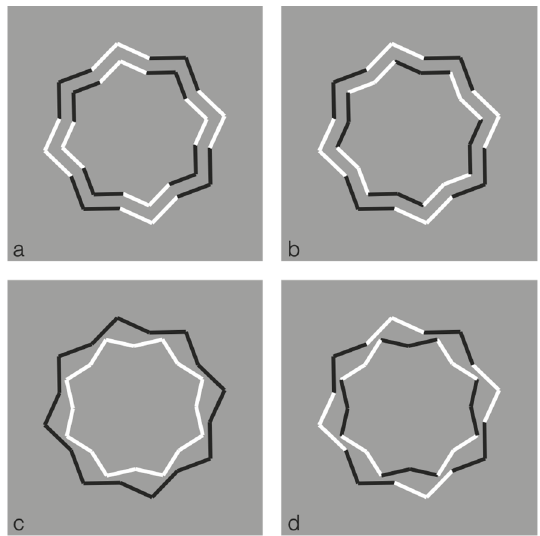
Figure 12. Regular and irregular shapes from reversed contrast.